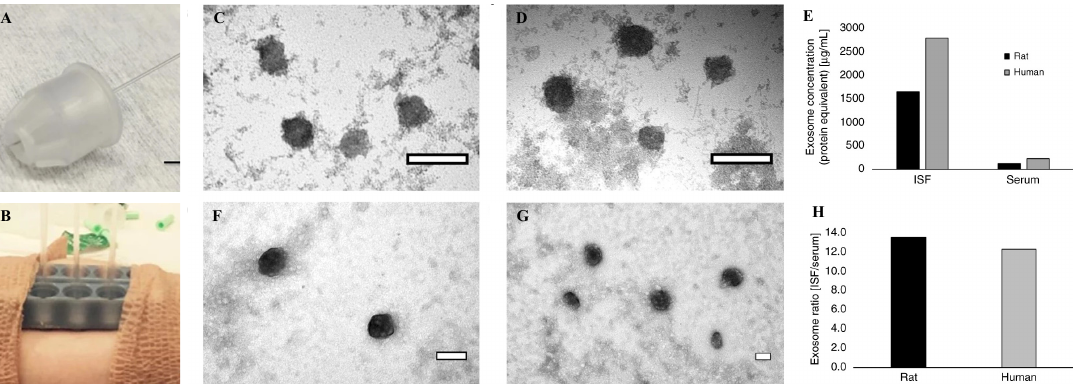
Figure 3. ( A ) The MN within polymer housing with glass capillary collection tube. ( B ) Two 3D MN holders were adhered to a human subject for interstitial fluid extraction and collection in capillary glass tubes. TEM images of rat ( C , D ) and human ( F , G ) exosomes purified from ISF ( C , F ) and serum ( D , G ) were exhibited. ( E ) Exosome concentration (protein equivalent) was measured using a NanoDrop system. ( H ) The exosome ratio of ISF vs. serum in rat and human samples were presented. Reprinted with permission from ref. [168].Copyright 2018, Nature.